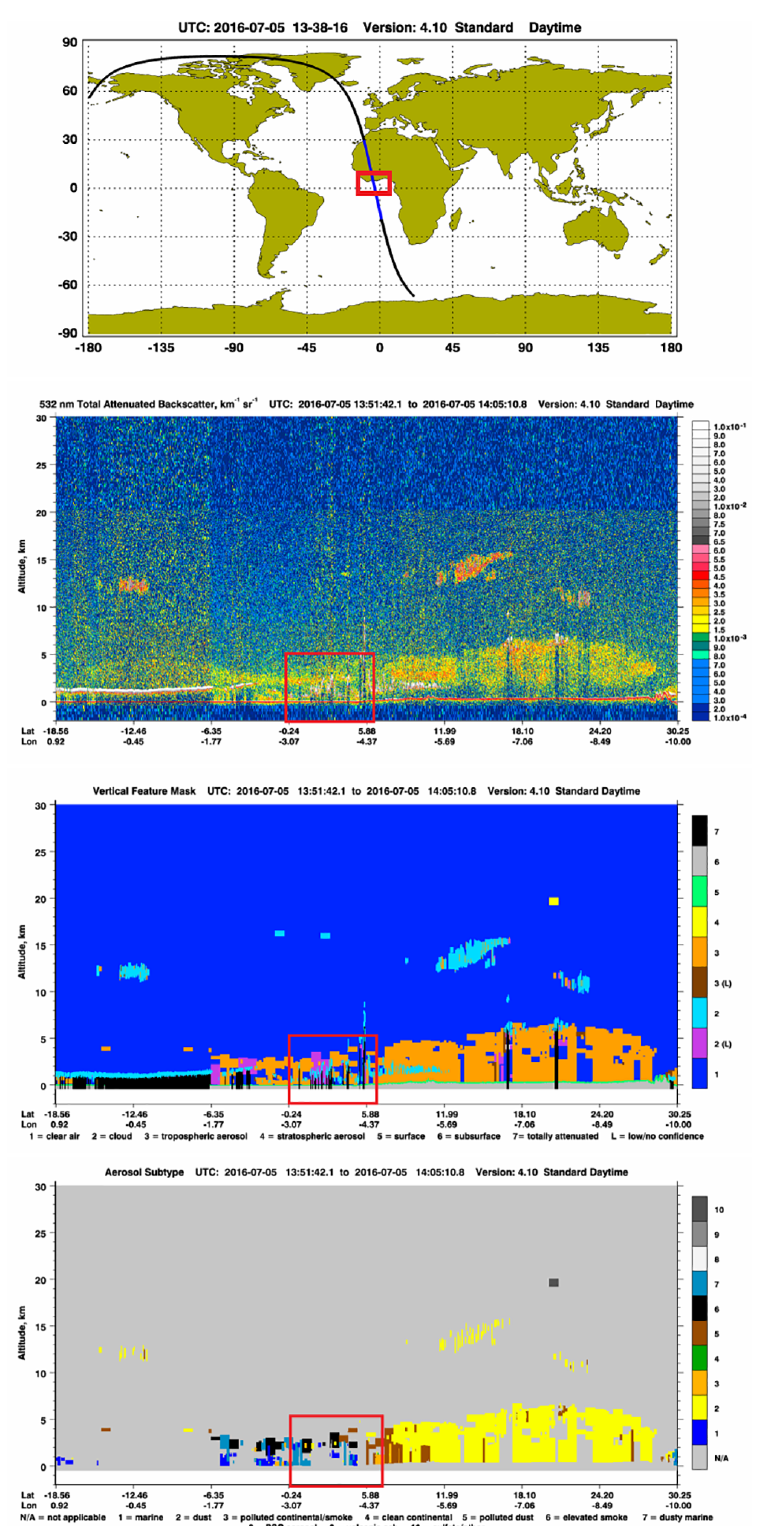
Figure A2. Space lidar CALIPSO data on board the CALIOP platform on 5 July 2016 with the orbit track location, the vertical profile of the total attenuated backscatter, the vertical feature mask, and the aerosol subtype. The modeling domain is the red box (data are available at https://www-calipso.larc.nasa.gov/, last access: 10 January